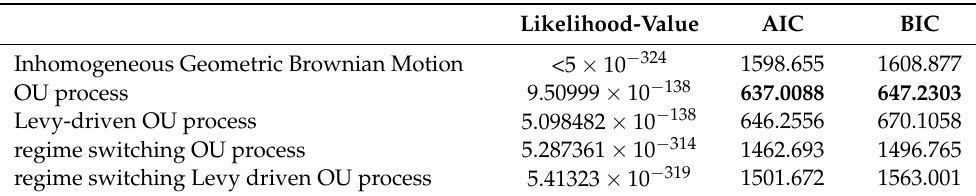
Table 11. Model comparison for energy-switching data using AIC and BIC, where 5 × 10 − 324 represents the smallest positive double in